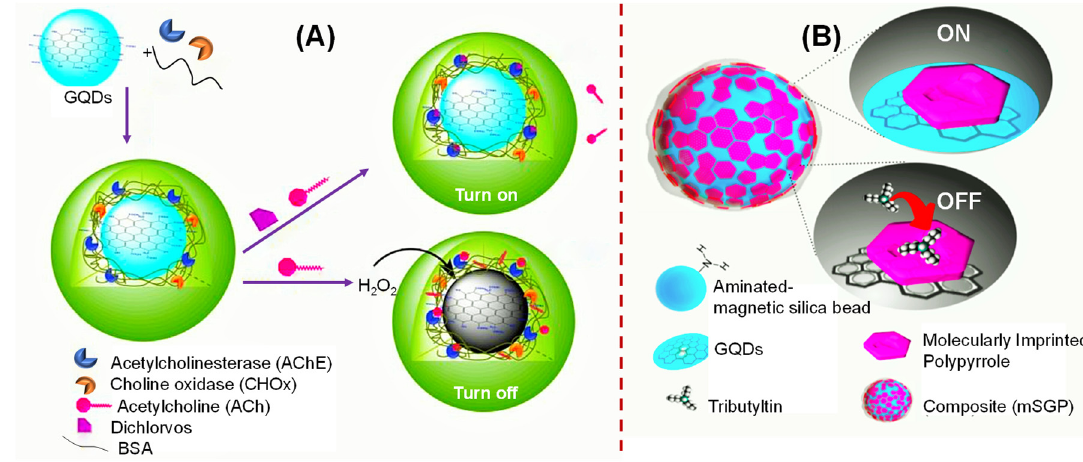
Figure 5. Schematic representation of: ( A ) Enzyme-based photoluminescence (PL) sensor for dichlorvos [143]; ( B ) MIP-based PL sensor for tributyltin [144].